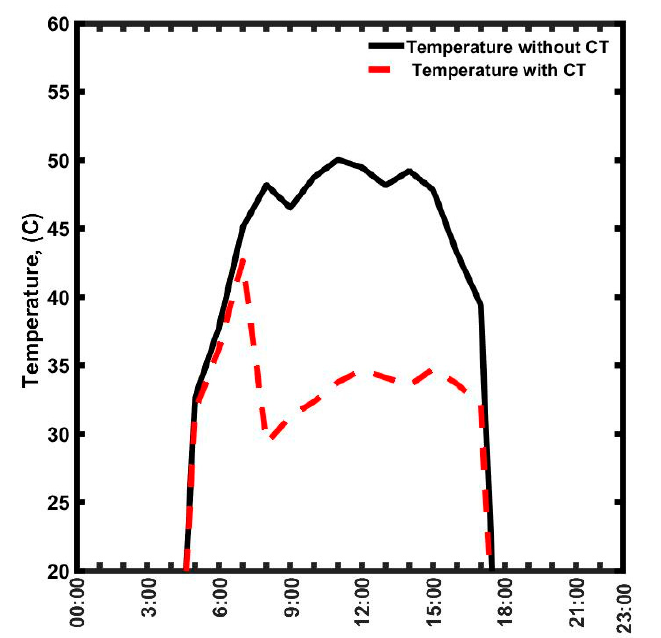
Figure 4. PV panels’ temperature profiles with and without the CT.